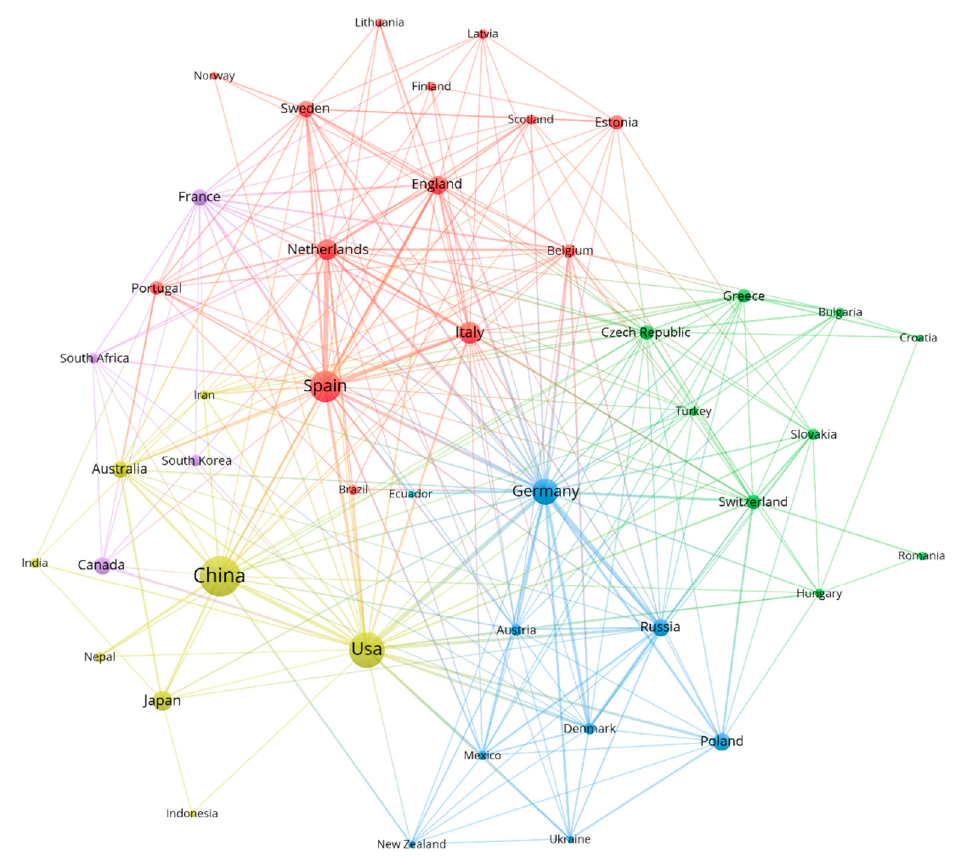
Figure 7. National collaborative network for research on farmland abandonment from 1980 to 2021.